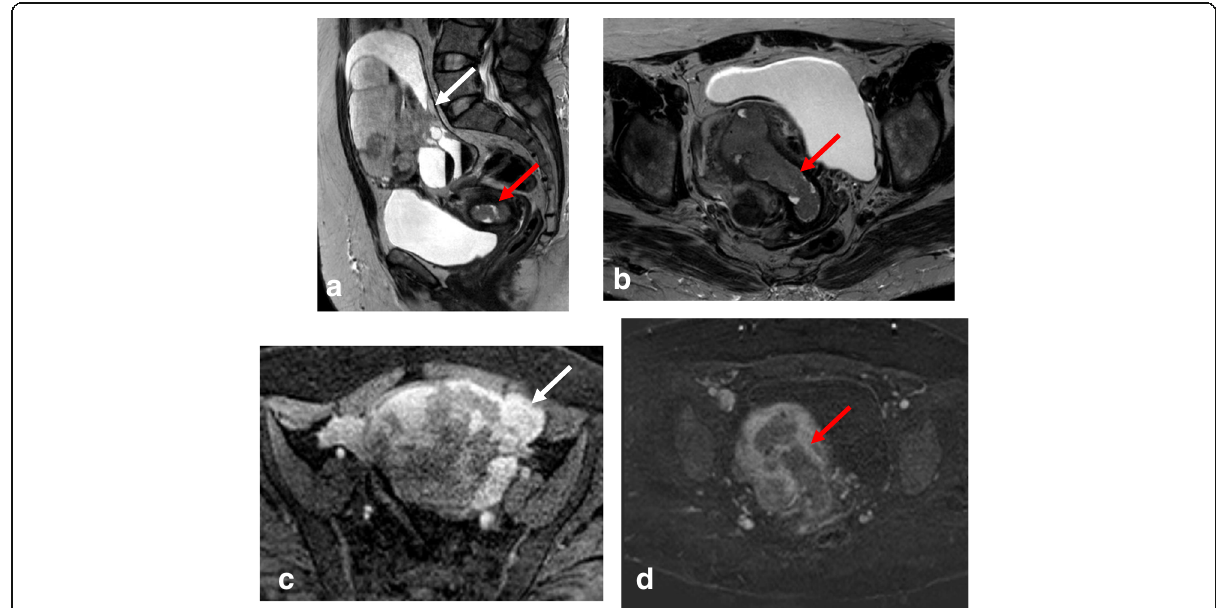
Fig. 8 Synchronous endometrial and ovarian cancer. Visualization by sagittal T2WI ( a ) and axial oblique T2WI ( b ) reveals a large multicystic ovarian mass (white arrow) and endometrial cancer (red arrow). c , d DCE imaging shows heterogeneous uptake in the ovarian mass (white arrow) and hypoenhancement in the endometrial mass (red arrow)